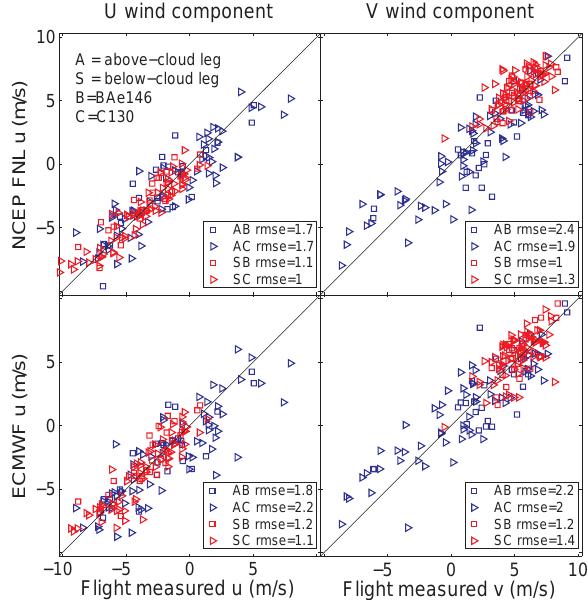
Fig. 8. Scatterplots of observed C130 and BAe146 leg-mean wind components u and v vs. NCEP FNL (top) and ECMWF operational (bottom) analyses, using all above-cloud (blue) and subcloud (red) legs flown within 1 ◦ latitude of 20 ◦